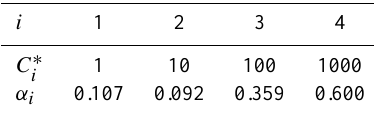
Table 2. Stoichiometric coefficients at T = 298K for the different volatility bins of the SOA precursor category TERP, with saturation concentration C ∗ inµgm − 3 from Tsimpidi et al. i